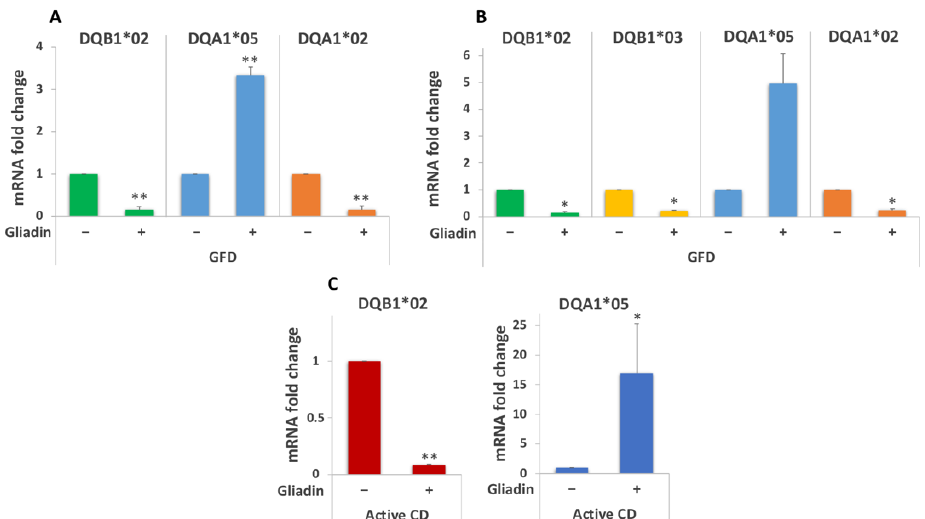
Figure 5. Analysis of DQ genes expression of macrophages from an Italian cohort. ( A ) DQB1*02, DQA1*05, and DQA1*02 mRNAs fold variation in GFD patients with the DR3/DR7 genotype ( n = 3: CD20, CD25, and CD31) after overnight gliadin stimulation (** p < 0.01). ( B ) DQB1*02, DQB1*03, DQA1*05, and DQA1*02 mRNAs fold variation in GFD patients with the DR5/DR7 genotype ( n = 2: CD26 and CD30) after overnight gliadin stimulation (* p < 0.05). ( C ) DQB1*02 and DQA1*05 mRNAs fold variation in active CD patients ( n = 3: CD14, CD34, and CD35) after overnight gliadin stimulation (* p < 0.05, ** p < 0.01).